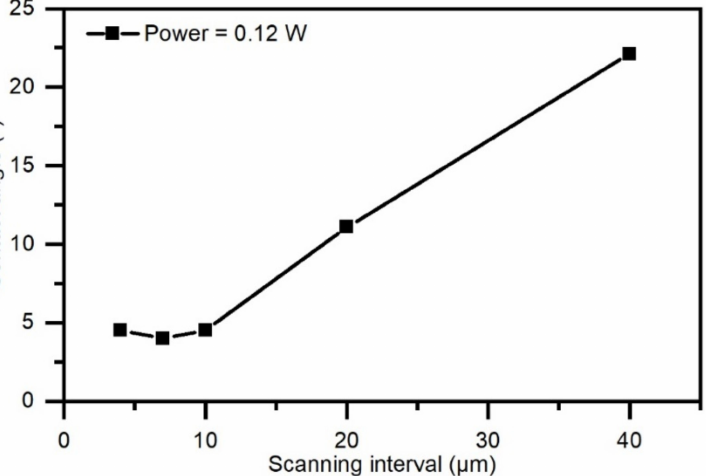
Figure 6. Contact angle of silicon irradiated by a femtosecond laser at different scanning